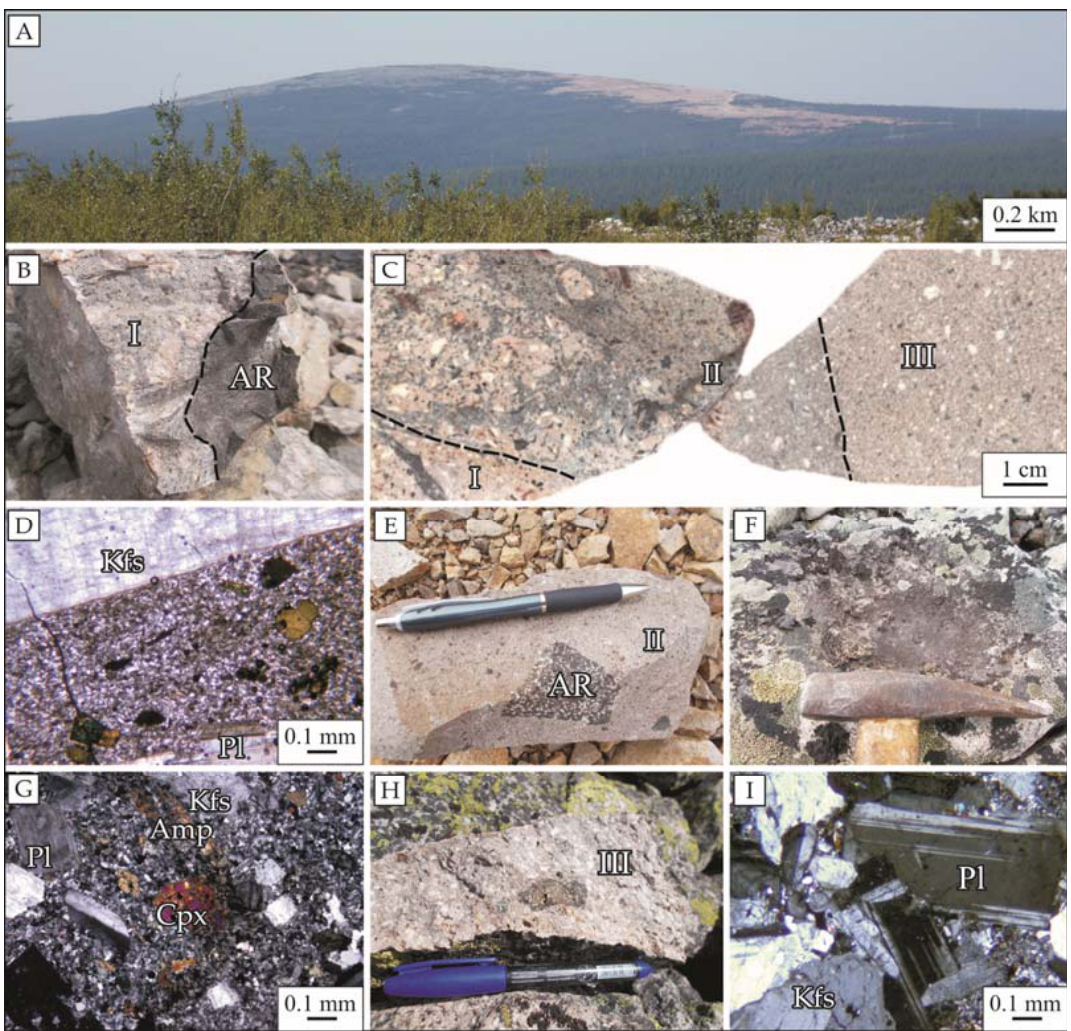
Figure 2. General view and petrography of rocks of the Medvedev massif. Rocks involved in the structure of the Medvedev massif: I—porphyry syenite, II—pyroxene ‐ amphibole syenite, III— quartz monzonite, AR—Precambrian host rocks of basement, Qz – quartz, Amp – amphibole, Pl – plagioclase, Kfs ‐ potassium feldspar, Cpx – clinopyroxene; ( A ) general view of Medvedev massif; ( B ) rocks of first phase of intrusion with xenolith of Precambrian schist; ( C ) contact between phases of massif; ( D ) thin section I19–19/4, porphyry syenite, phenocryst of Kfs larger 2 cm, magnification 40x, crossed nicols; ( E ) rocks of second phase with xenoliths of Precambrian schists; ( F ) miarols in